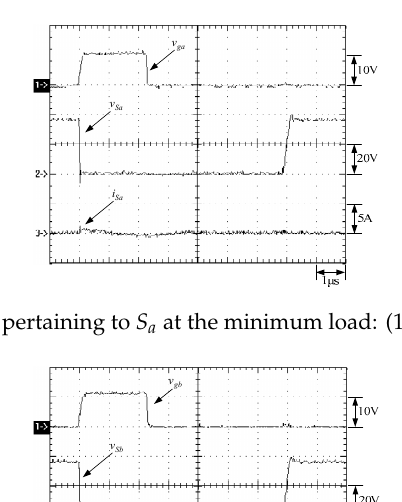
Figure 19. Waveforms pertaining to S 1 at the minimum load: (1) v g 1 ; (2) v S 1 ; and (3) i S 1 .